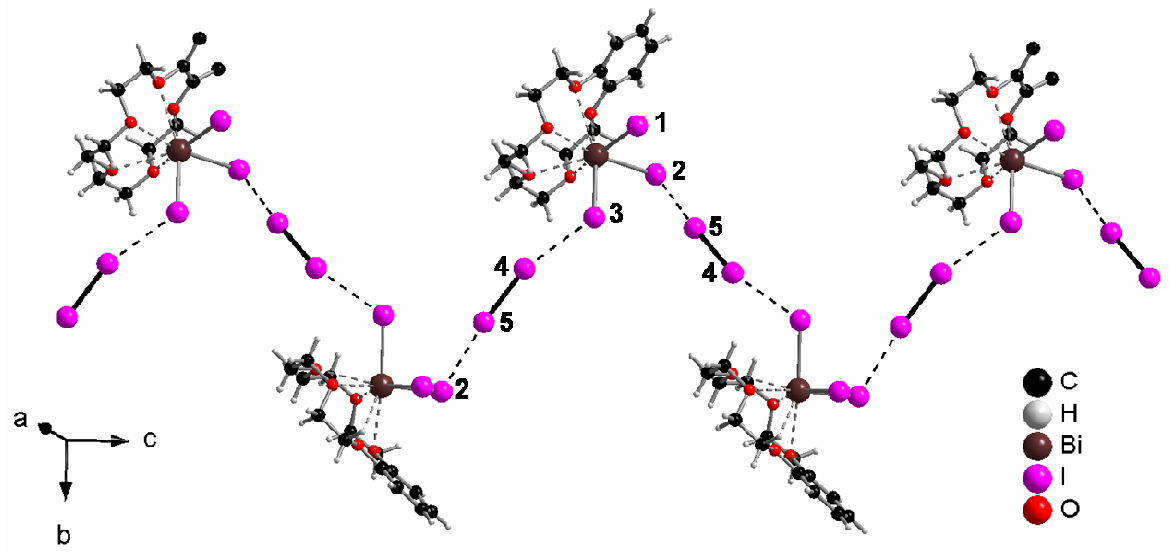
complexes bridged by iodine molecules 3 (I ). 3 2